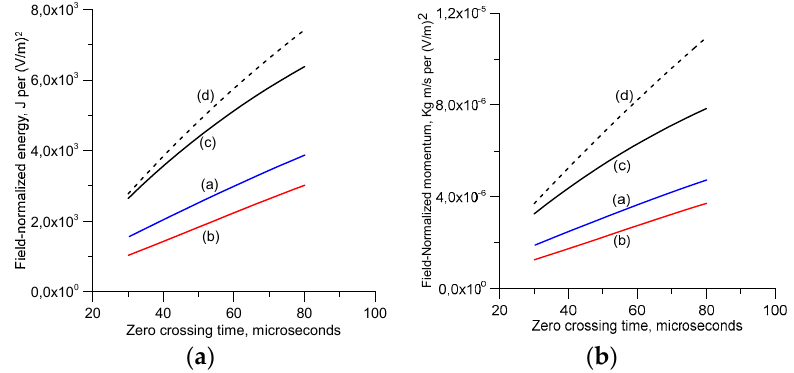
Figure 11. The field-normalized energy and momentum radiated by a first return stroke simulated by the transmission line model. The peak channel base current is 30 kA. ( a ) Field-normalized energy. ( b ) Field-normalized momentum. (a) MTLL model; (b) MTLE model; (c) TL model with speed equal to 10 8 m/s; (d) TL model with speed equal to the speed of light.